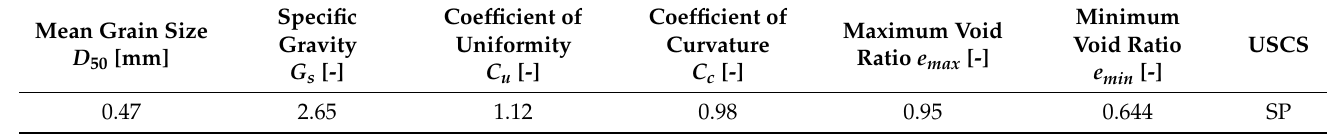
Table 1. Properties of sand used in this